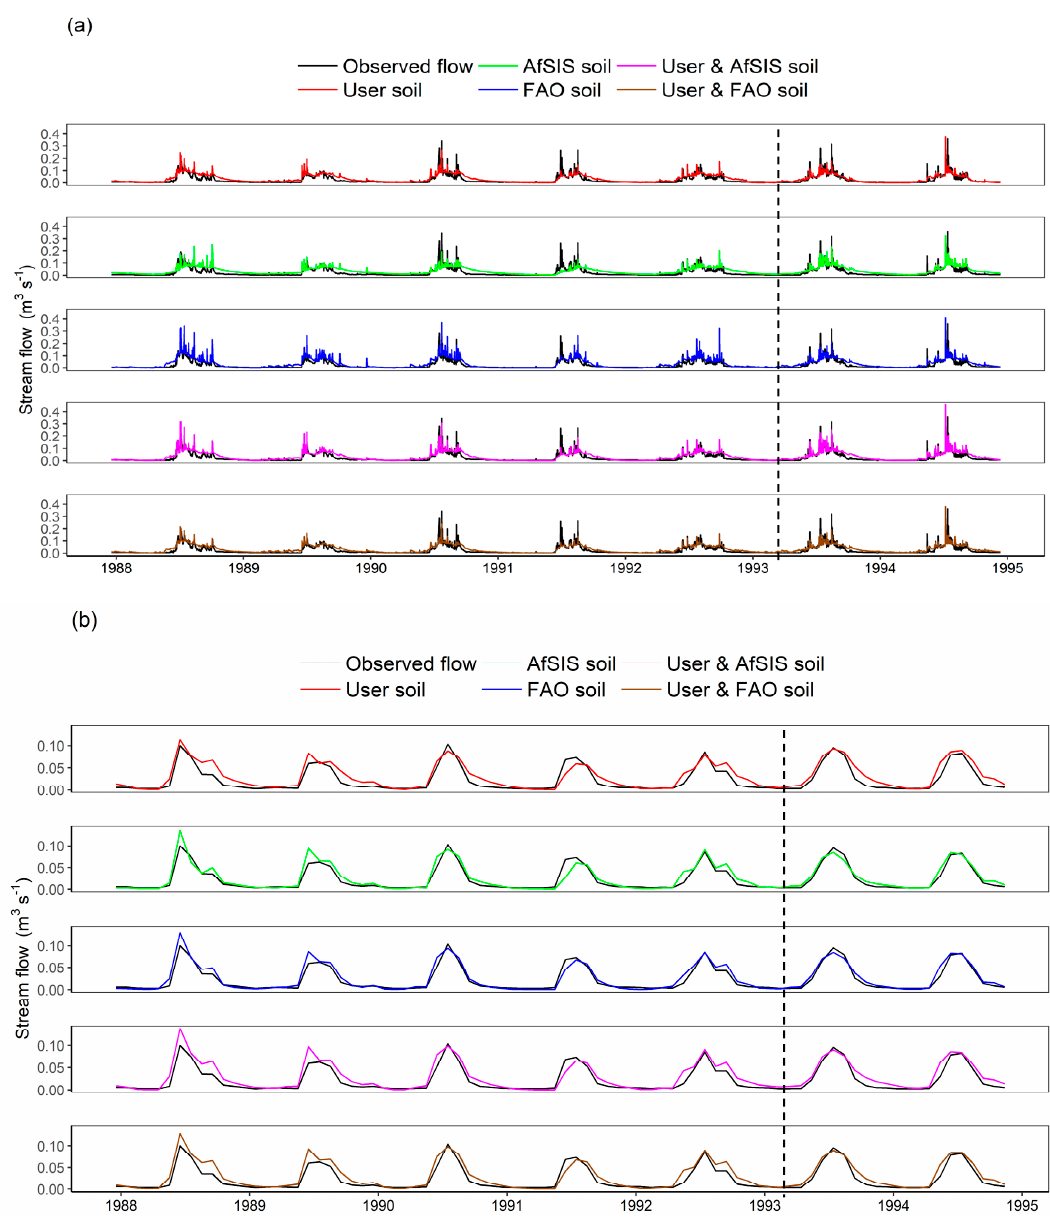
Figure 6. Comparison of measured and simulated streamflow after model calibration at the watershed outlet. Daily simulations ( a ) and monthly simulations ( b ). The vertical lines divide model calibration ( left ) and validation ( right ) periods.